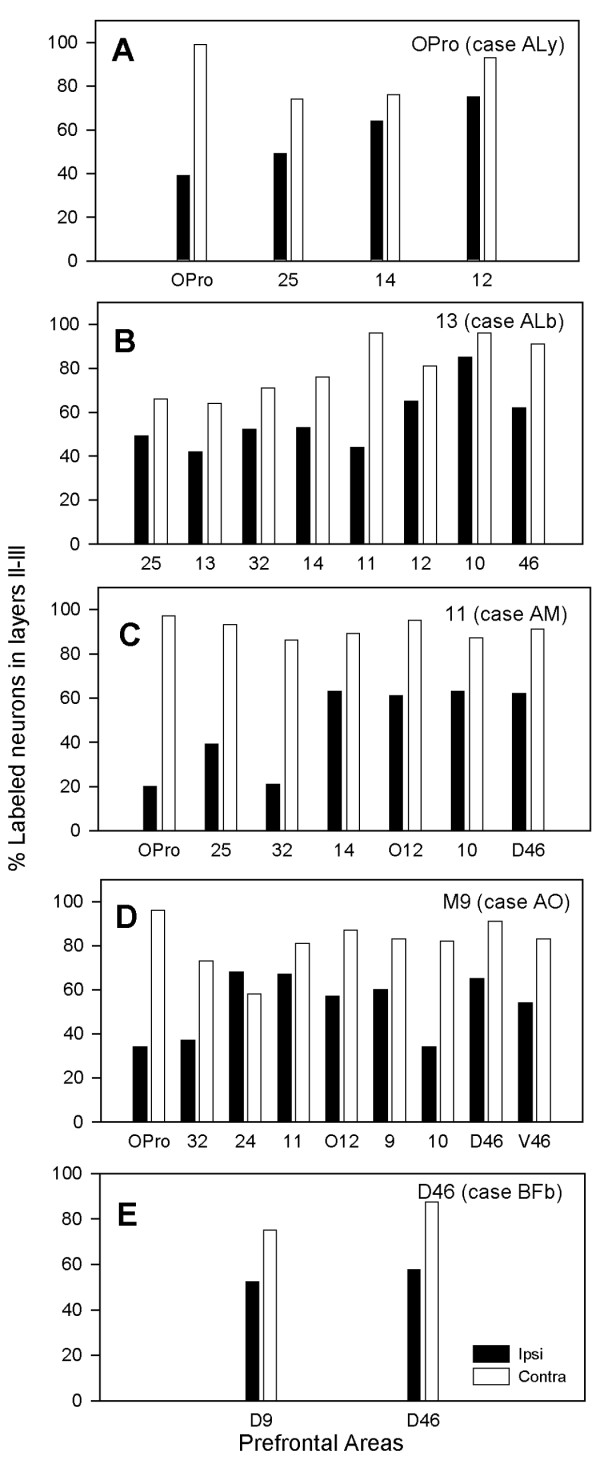
Comparison of the distribution of projection neurons in the supragranular layers II-III in matched areas on the contralateral and ipsilateral hemispheres for individual cases. (A-C) Areal distribution of projection neurons in cases with injection of tracer in orbitofrontal areas (area OPro, case ALy; area 13, case ALb; area 11, case AM); (D) In a case with injection of tracer in medial area 9 (case AO); (E) In a case with injection in dorsal area 46 (case BFb). In all cases the prevalence of projection neurons in layers II-III in most areas is higher on the contralateral side (silhouette bars) than on the ipsilateral side (black bars).